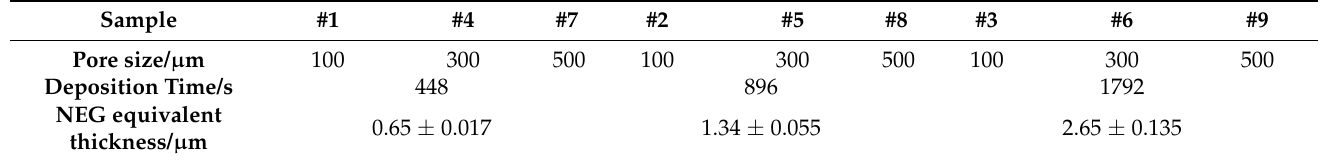
Table 1. Detailed parameters for NEG coating